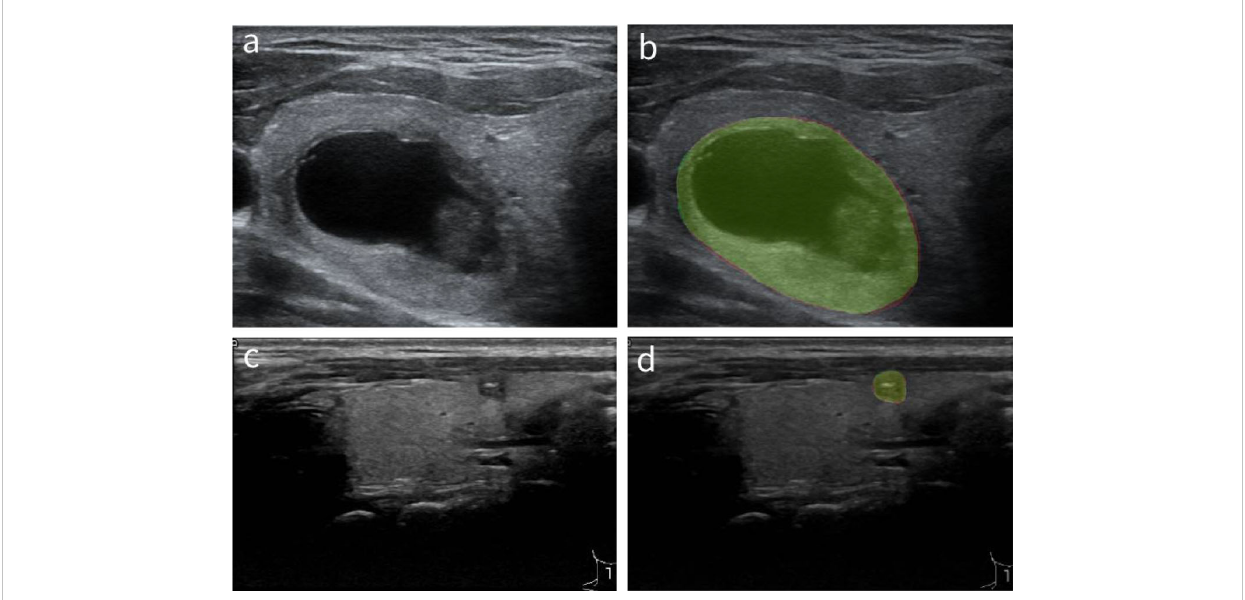
FIGURE 6 Comparison of the masks generated by the AI system and the masks outlined by the radiologists. (A, C) The original thyroid ultrasound images. (B, D) Masks generated by the AI system and radiologists, where the red segments are produced by the AI system, and the green ones are manually drawn by the radiologists. AI, arti fi cial